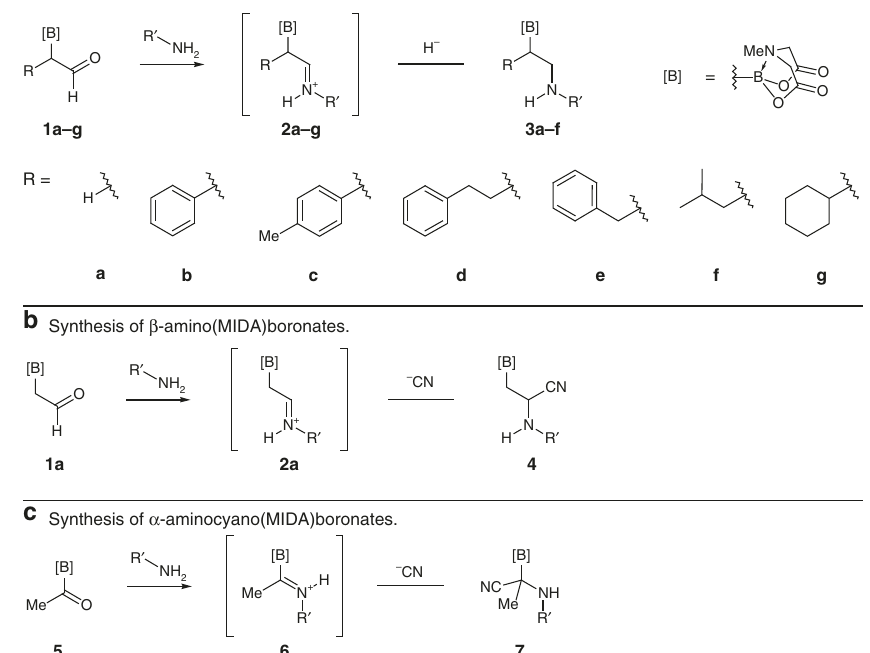
Fig. 2 General synthesis of the MIDA boronates developed in this study. a Synthesis of β -amino(MIDA)boronates using a reductive amination approach. b Synthesis of β -aminocyano(MIDA)boronates using a reductive cyanation approach. c Synthesis of α -aminocyano(MIDA)boronates using a reductive cyanation